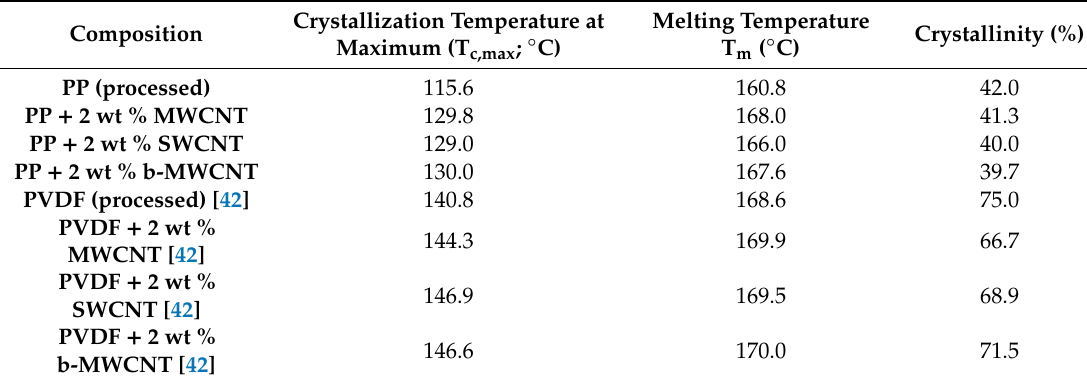
Table 2. DSC melting and crystallization temperatures and